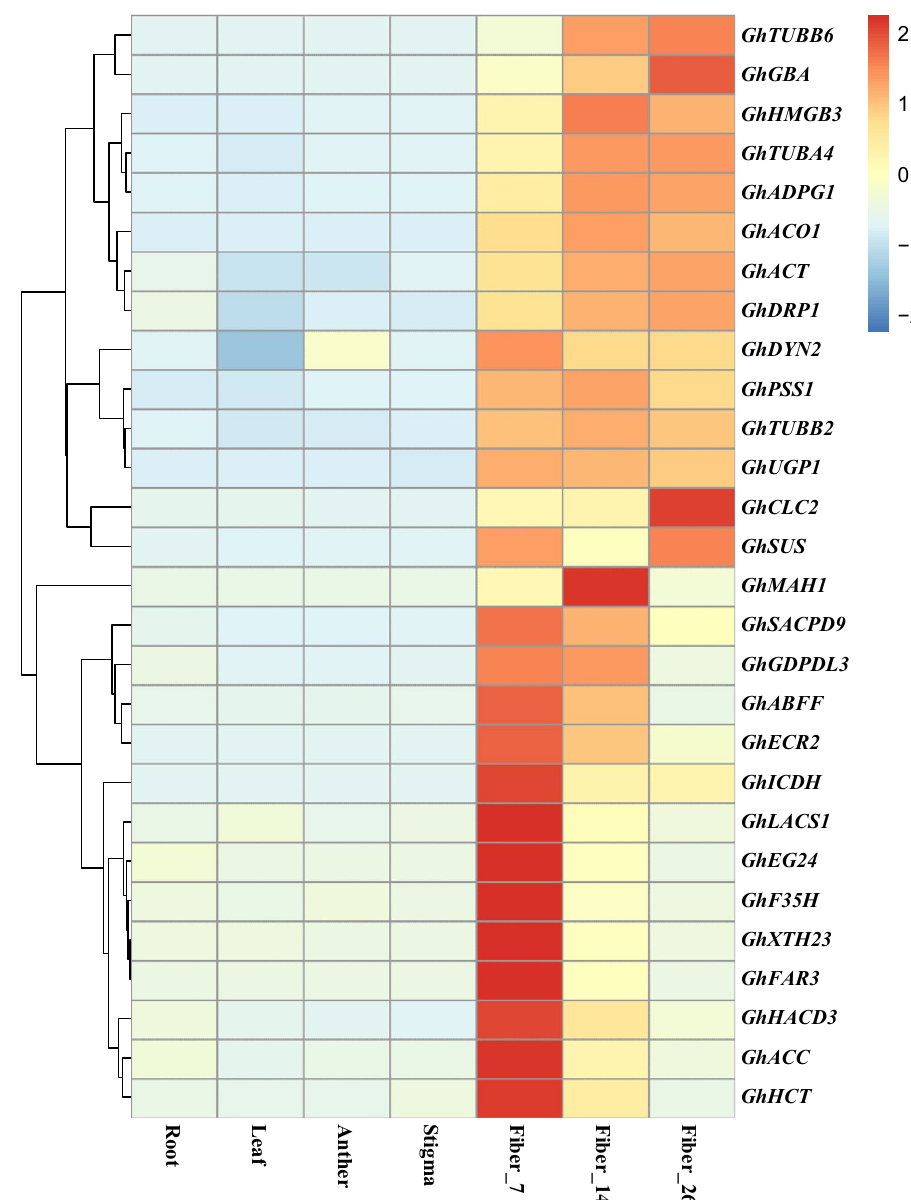
Figure 7. Heatmap of related functional genes during fiber elongation and development (p value < 0.05, |Log2(Fold Change)| ≥ 2 at one sampling